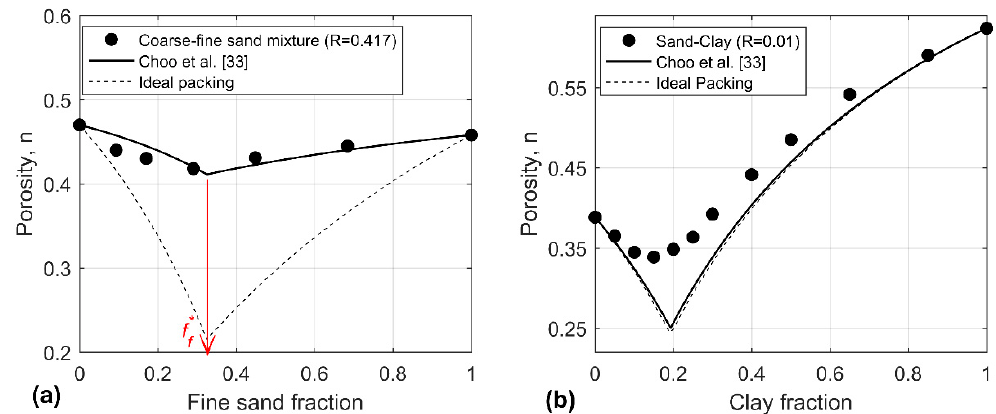
Figure 1. Prediction of porosity as function of fine particles mass fraction for: ( a ) coarse and fine sand mixture (data from Choo et al. [33]); ( b ) sand-clay mixture (data from Marion et al. [20]). The prediction of the ideal packing model is shown in dashed curve while the prediction of non-ideal packing model (Choo et al. [33]) is shown in solid curve. All equations can be found in Choo et al. [33]. f ∗ refers to the critical fine fraction at which the minimum porosity is observed.